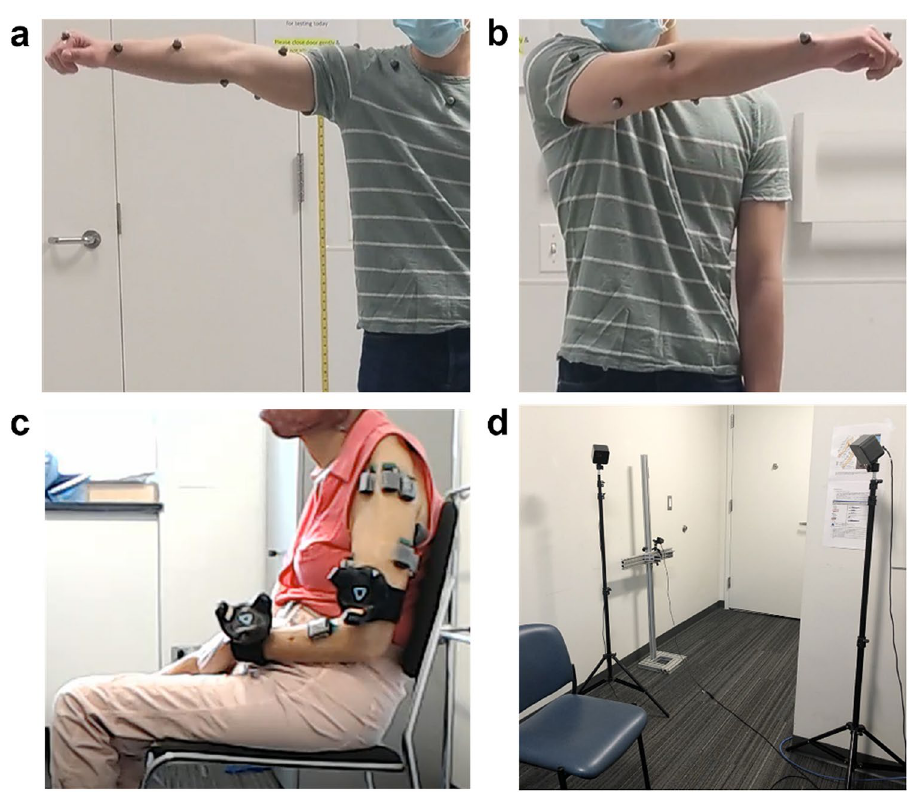
Figure 2. Vicon upper extremity (UE) marker setup and an example sensor setup on participants. ( a ) Vicon marker placements on the anterior arm, anterior forearm, and radial wrist. ( b ) Vicon marker placement on the posterior arm and ulnar wrist. ( c ) The IMU and Vive setup on a participant with stroke. The additional sensors on the UE are electromyography sensors. ( d ) Example Vive lighthouse positioning for tracking the left side of the participant (who would be seated in the chair as